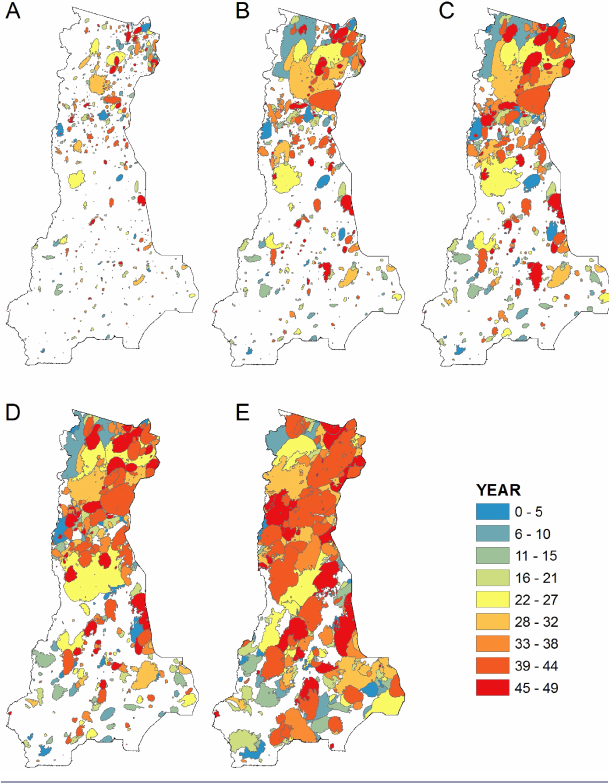
Fig. 3 . Simulated fire perimeters in the study area from one 50- year Envision simulation for five wildfire scenarios: 1X (A), 2X (B), 3X (C), 4X (D), and 10X (E). Increased levels of wildfire activity in each scenario were achieved by multiplying the burn period of each ignition over contemporary levels by the multiplier